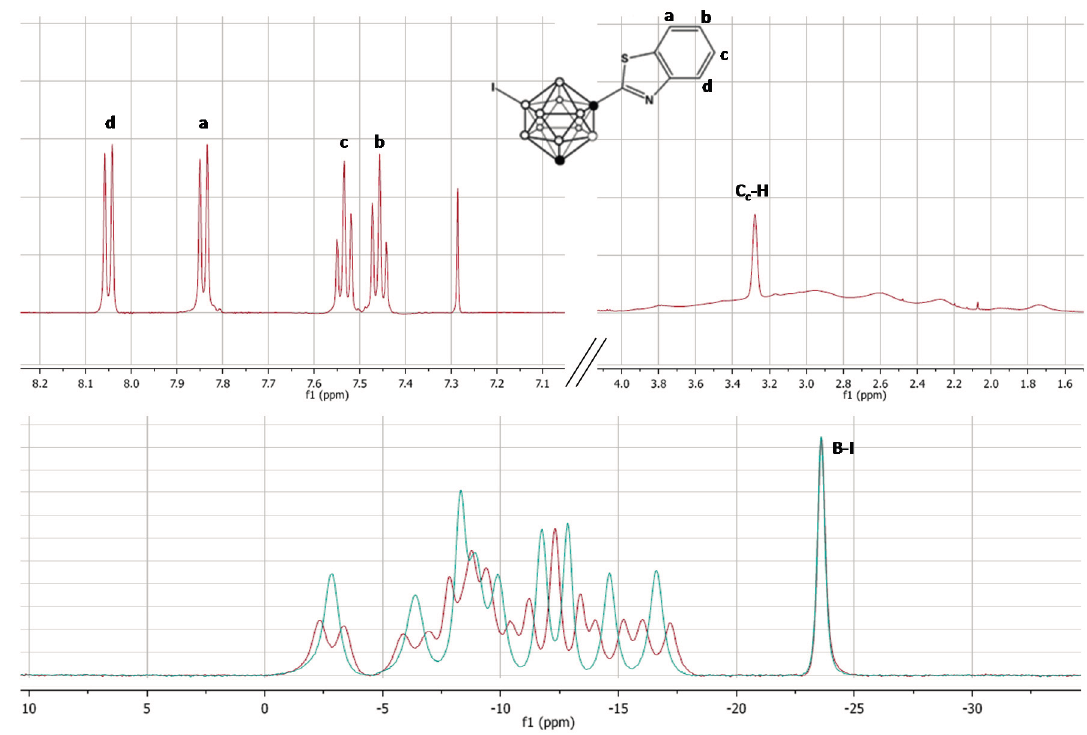
Figure 3. Top: 1 H-NMR spectra for compound 5 ; bottom: 11 B- ( red ) and 11 B{ 1 H}-NMR ( blue ) spectra for compound 5 . The presence of four signals (integration 1:1:1:1) in the aromatic region and one signal (integration: 1) in the C c -H region (top) together with the presence of a singlet in the 11 B-NMR spectra ( − 23.55 ppm) confirm the incorporation of the iodine atom on one of the boron atoms of the carborane cage. a, b, c and d identify the four protons in the aromatic ring and the corresponding signals in the 1 H-NMR